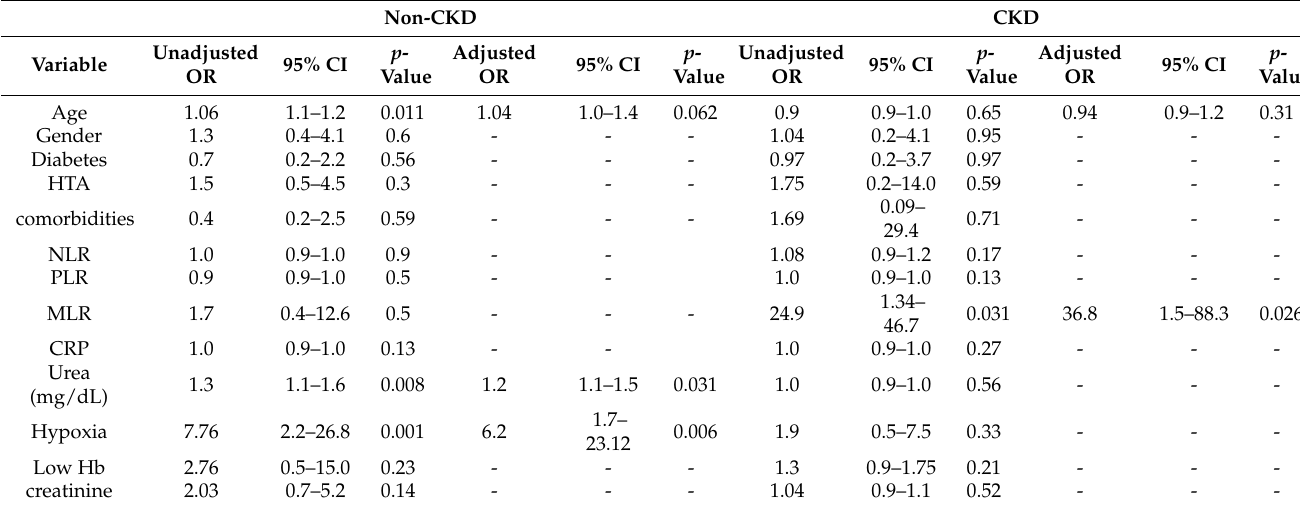
Table 5. Univariate and multivariate logistic regression (subgroup